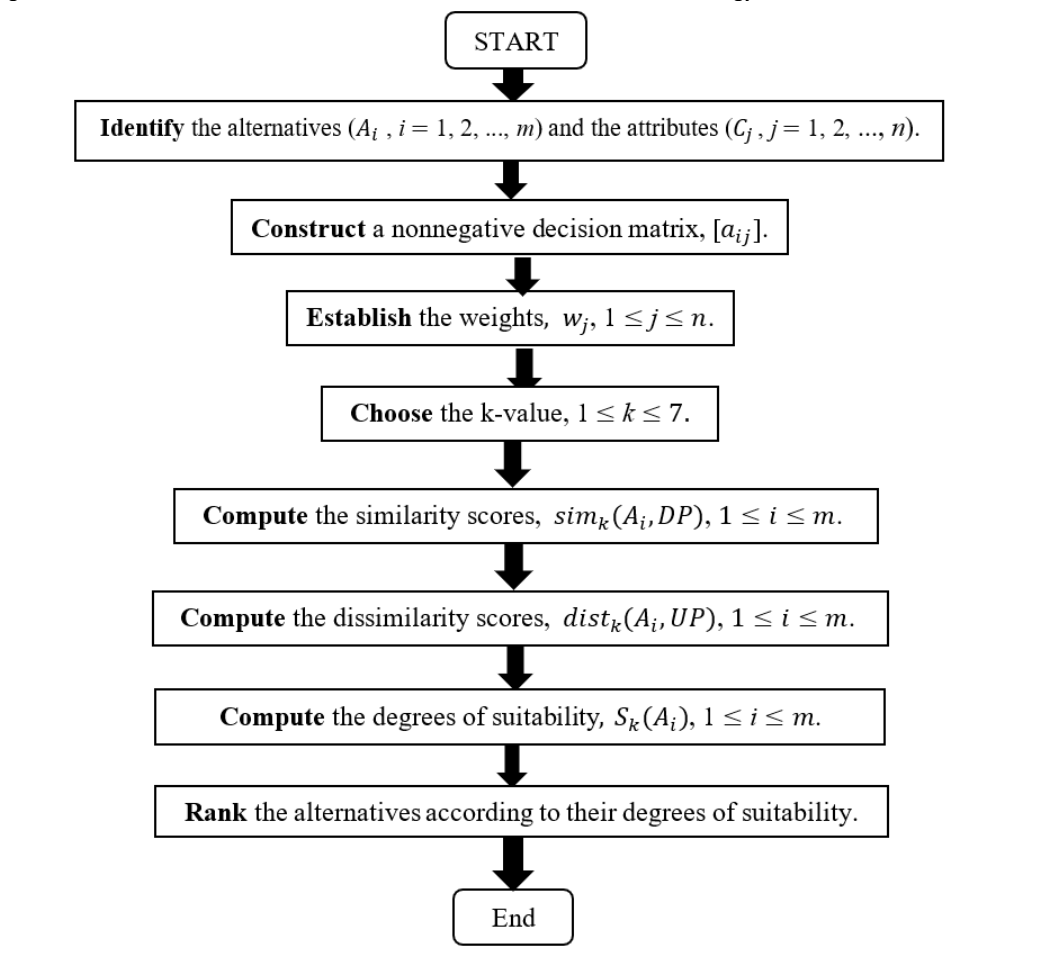
Fig. 1. Flowchart of the WESNORD metrics based